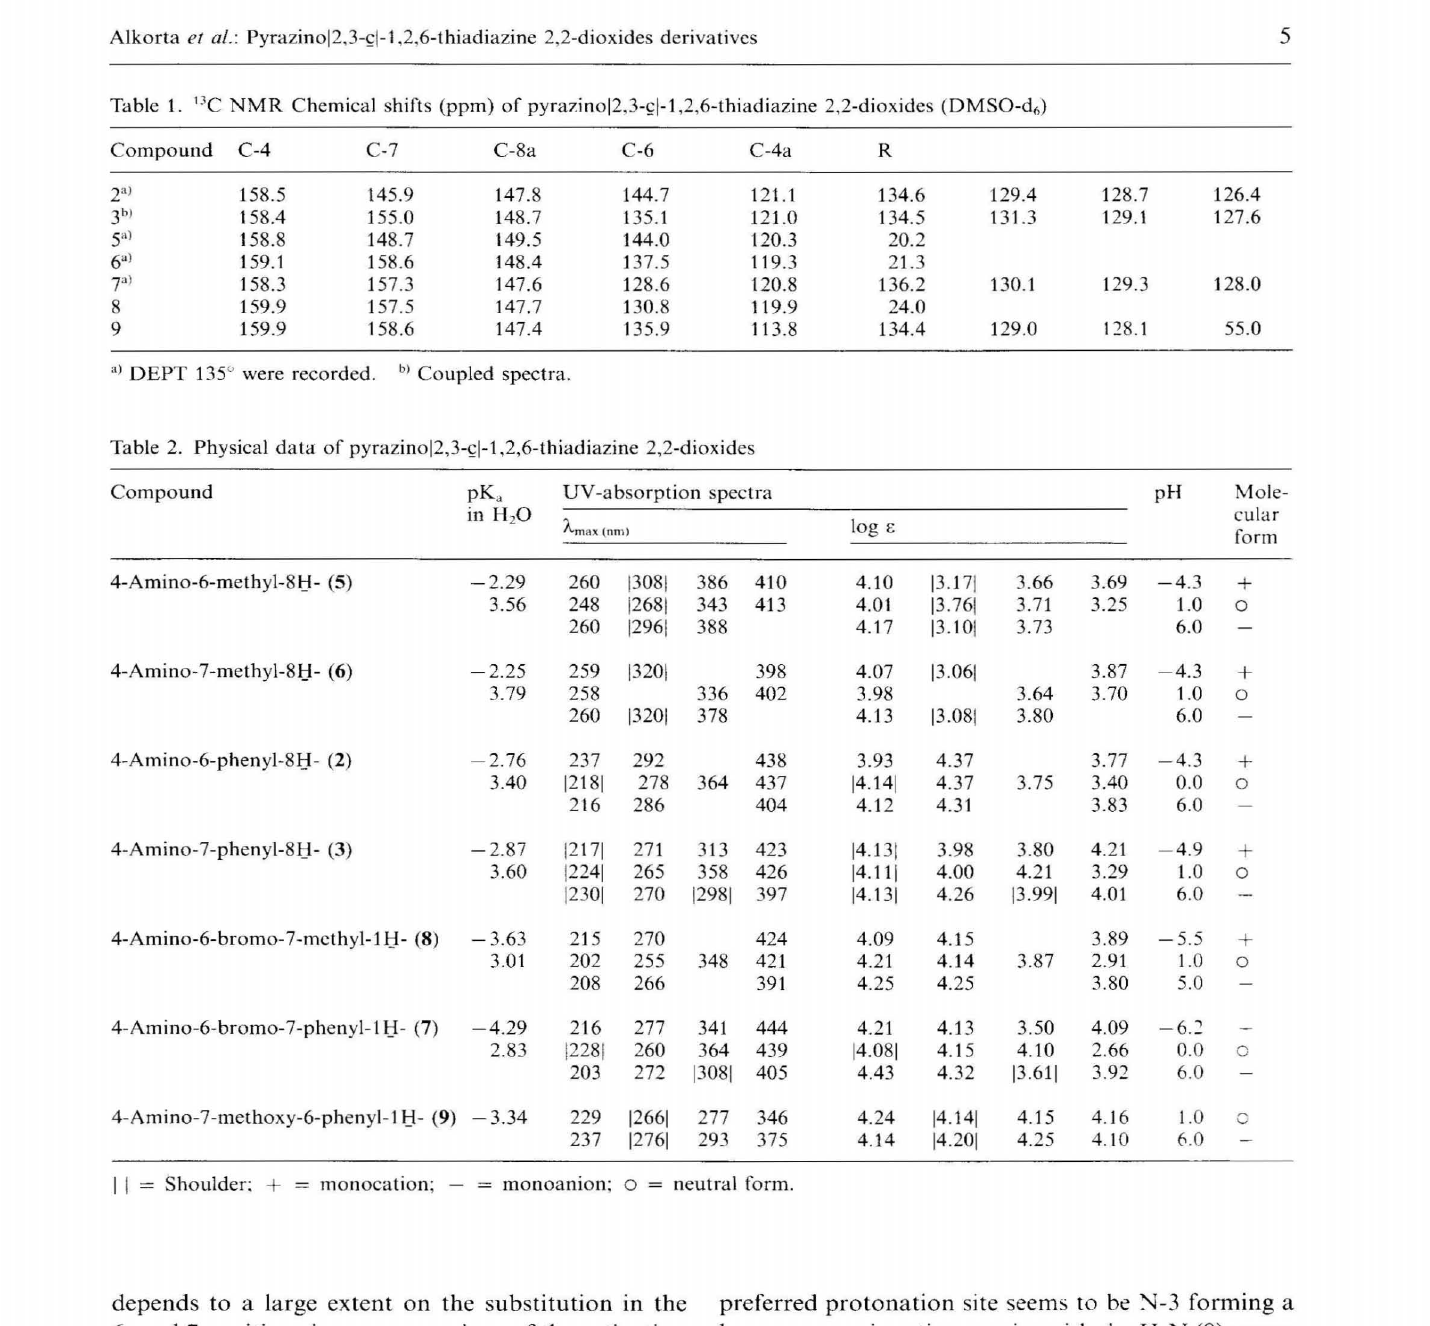
Table 2. Physical data of pyrazinoI2,3-~I-l ,2,6-thiadiazine 2,2-dioxides Compound pKa